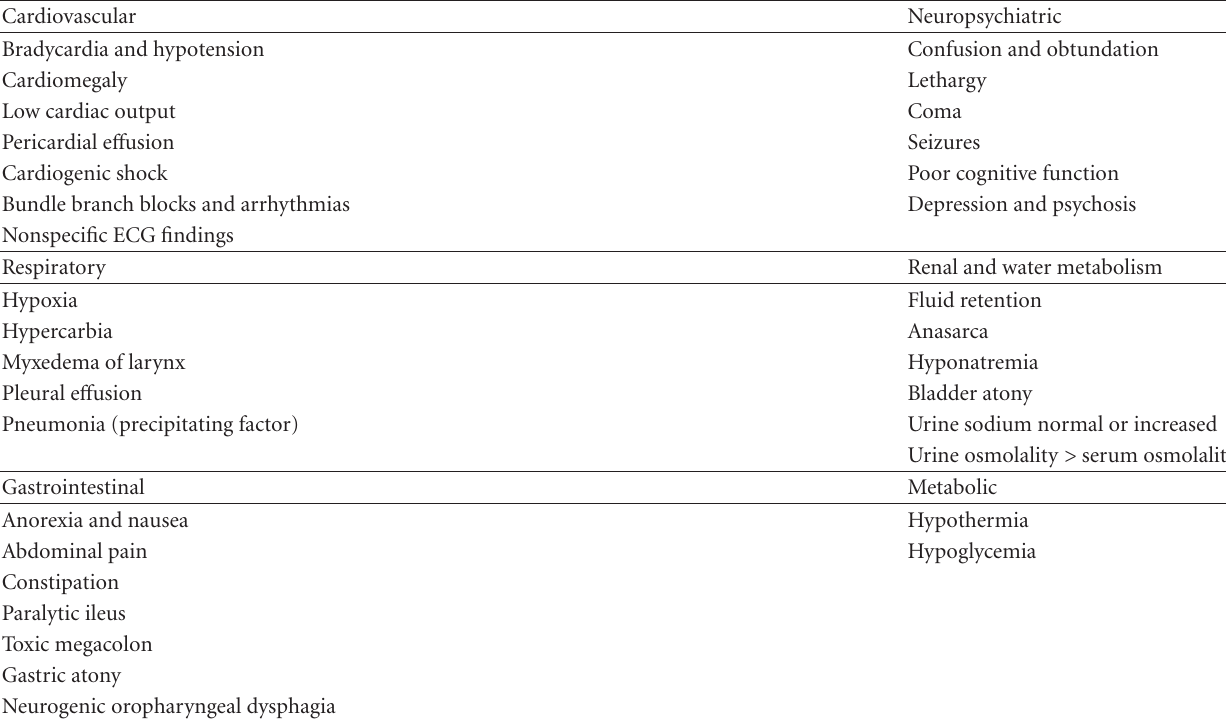
Table 1: Clinical and laboratory features of myxedema